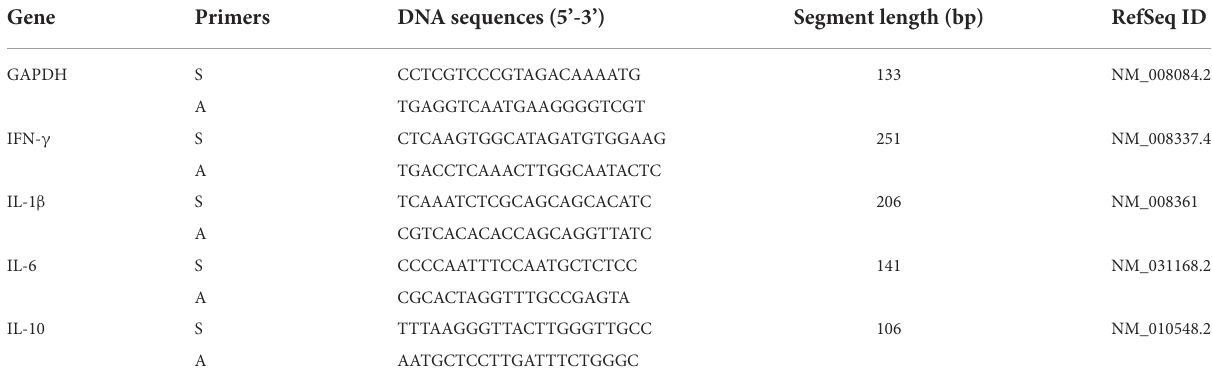
TABLE 2 Primers used for inflammatory cytokines. Gene Primers DNA sequences